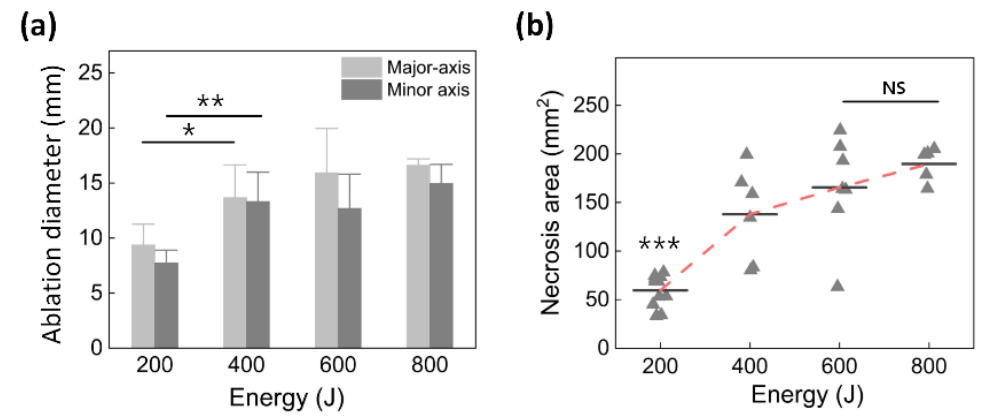
Figure 4. Quantitative comparison of ( a ) ablation diameter (KW p < 0.001; * MU p < 0.05 and ** MU p < 0.01 vs. 400 J) and ( b ) necrosis area measured from histology images of treated pancreatic tissue as function of total energy delivery (KW p < 0.001; *** MU p < 0.001 vs. 400 J; NS: no significant difference between 600 J and 800 J, p = 0.43).